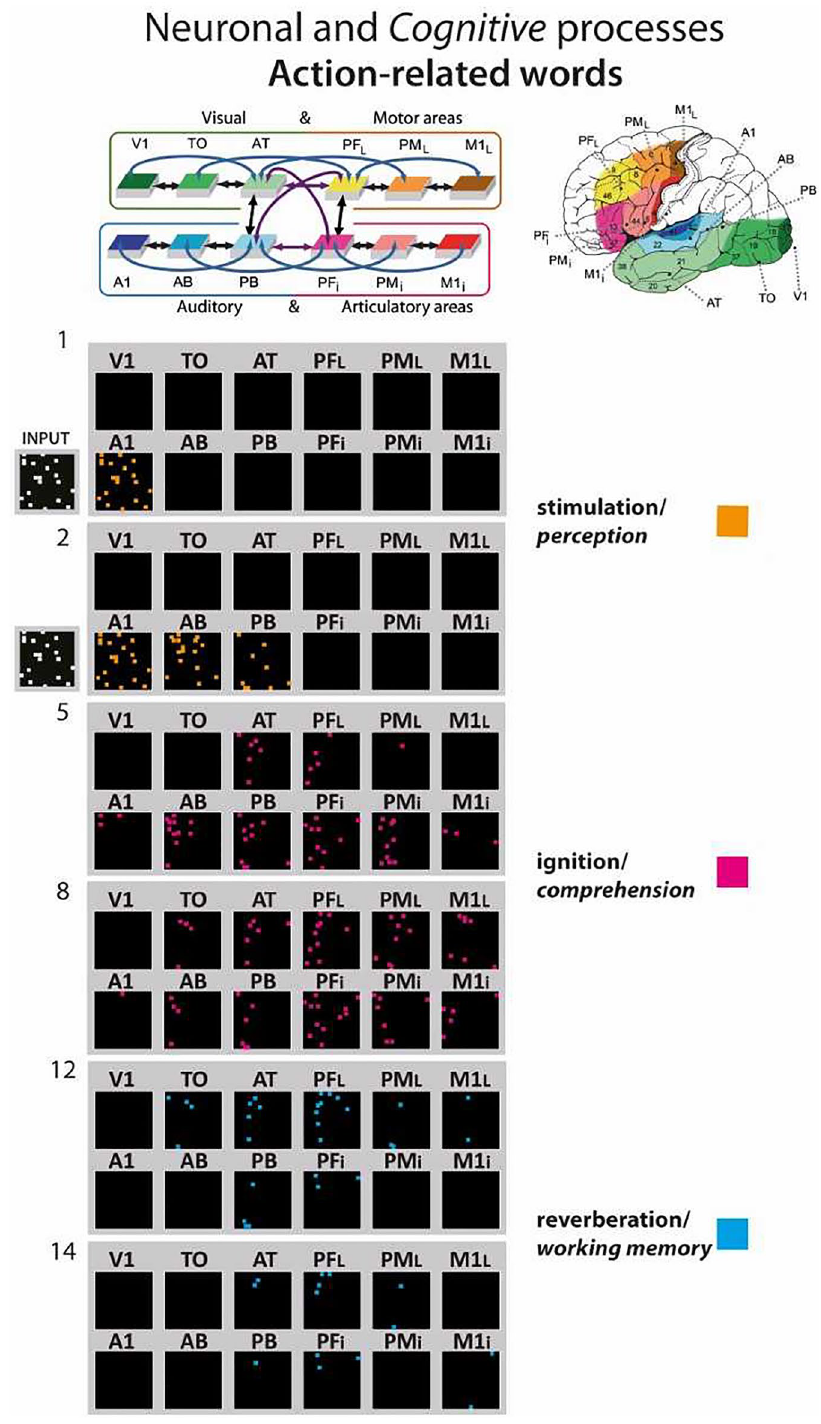
Figure 1. Simulated action word processing in a biologically constrained spiking network model of the fronto-temporo- occipital lobes. After the network underwent action word learning by interlinking acoustic, articulatory and action-semantic information, the action-word-related circuit was re-activated by auditory stimulation to areas A1(word recognition). The re-activation process comes in different consecutive neuronal and cognitive phases, the stimulation phase, which corresponds to word perception (orange pixel), the full activation or ‘ignition’ phase, the correlate of word comprehension (magenta pixel), and the reverberant maintenance of activity, which underpins verbal working memory (blue pixels). Please note the relatively prominent role of prefrontal cortex in the reverberation and working memory phase, which motivates the prediction of an anterior frontal activity shift. At the top right, the 12 brain areas modelled are shown. The top left box-and-arrow diagram shows the structure of the network; box colours and positions indicate correspondence to brain area and arrows between area connectivity. Sets of 12 black squares in the main diagram below represent activation of the same 12 areas at a given simulation time step. Simulation time steps are indicated on the left. Each coloured dot represents one active (spiking) model neuron at a given time step. Figure adapted from Tomasello et al. 60